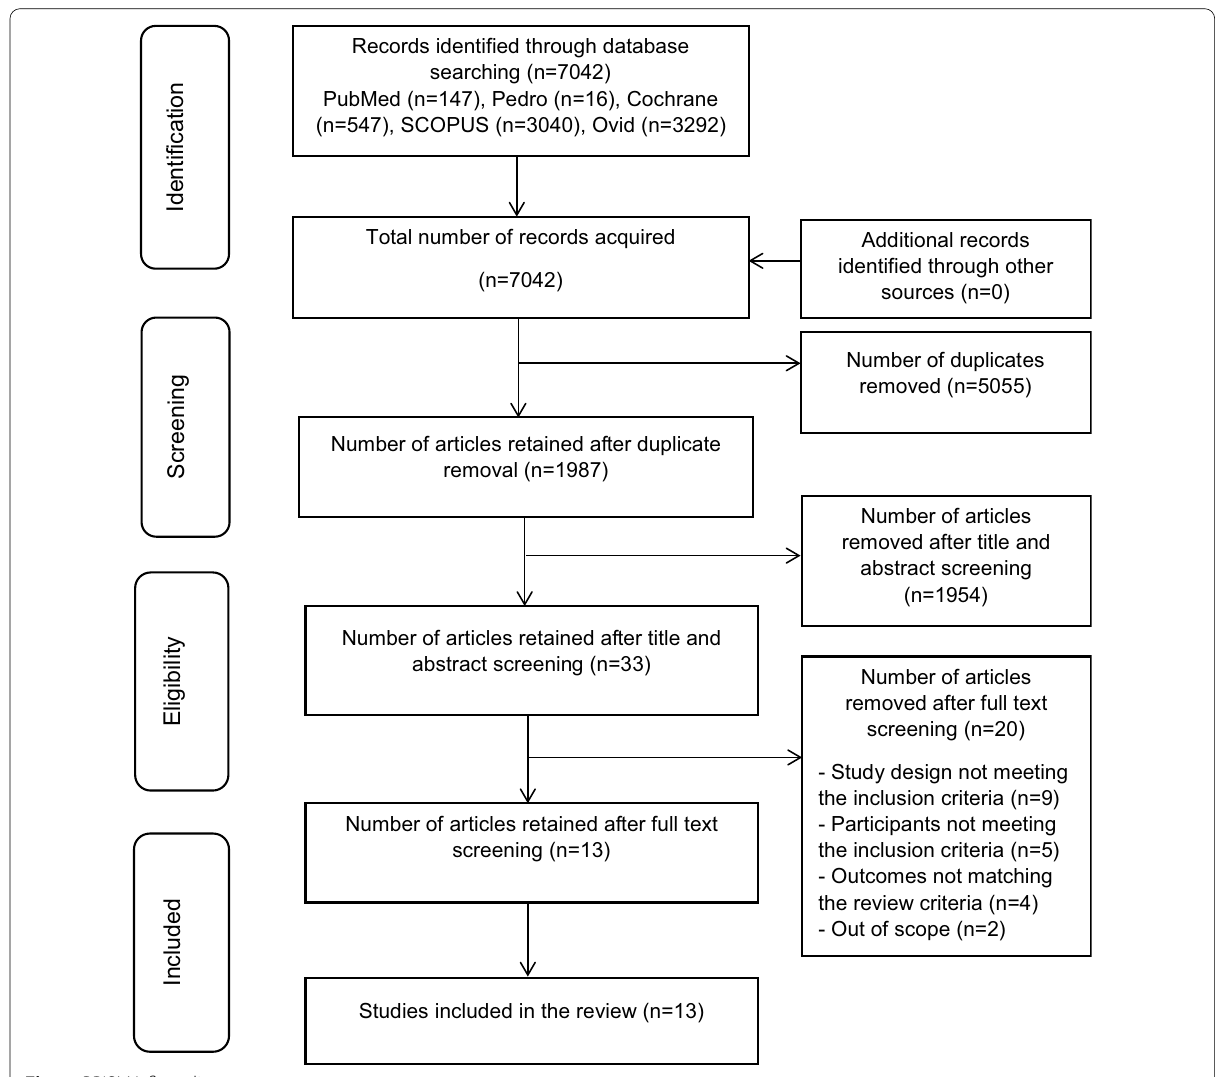
Fig. 1 PRISMA flow